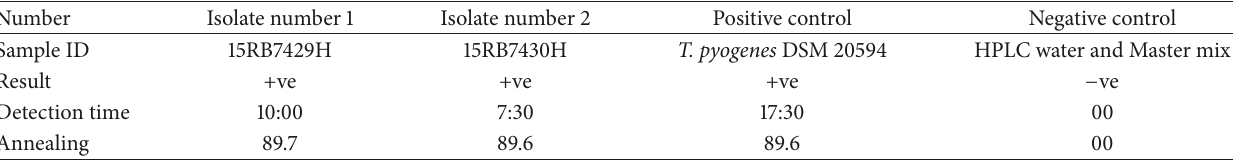
Table 1: Results of LAMP including detection time and annealing temperature of each isolate and positive and negative control.